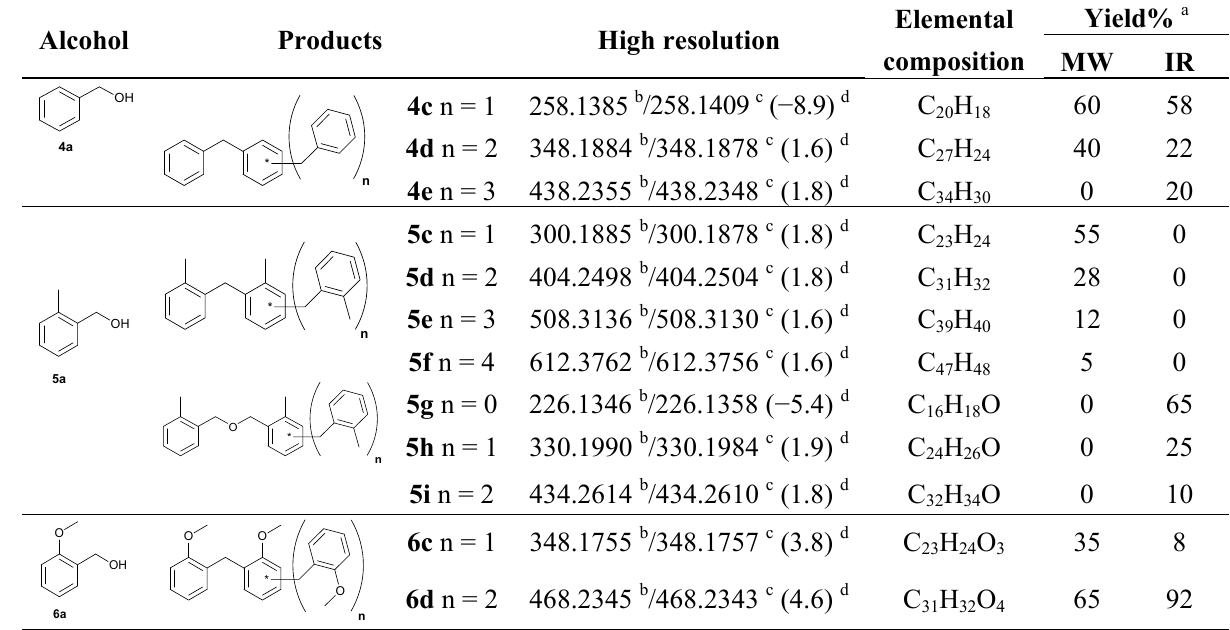
Table 3. Elemental composition and high resolution data of oligotoluenes.